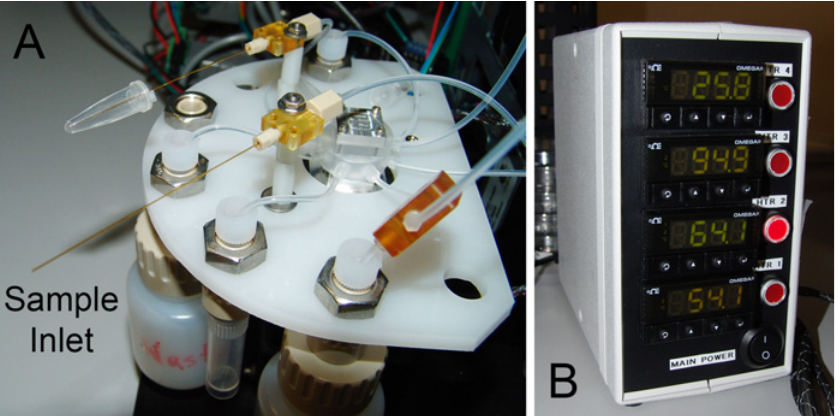
Fig 5. rzPCR system hardware. (A) Detail of the sample inlet and reagent distribution portion of the rzPCR system. Sample is aspirated into the capillary shown in the foreground, while the capillary in the back will deliver PCR reagents to a DMF platform in future iterations of the system. Reagent, flushing, and waste reservoirs plumbed to the central multiport valve can be readily emptied or refilled as needed. (B) Four- channel heater control